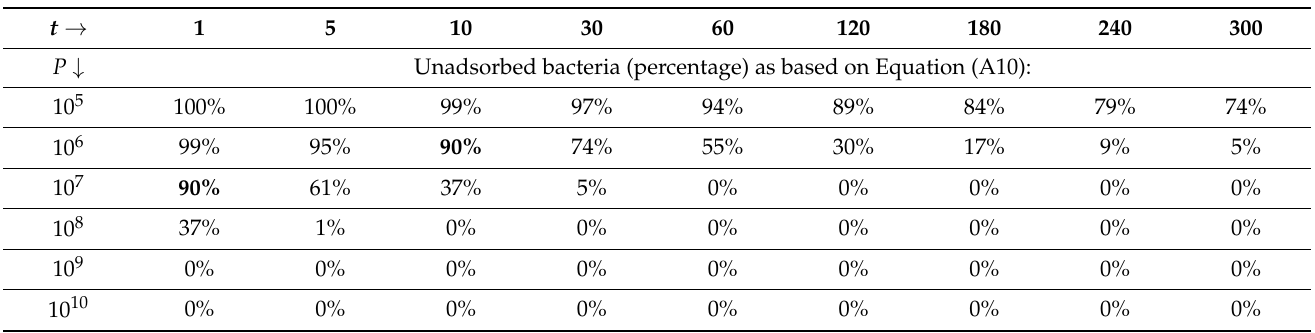
Table A1. Percentage of bacteria remaining unadsorbed as functions of phage titers ( P ) and adsorption